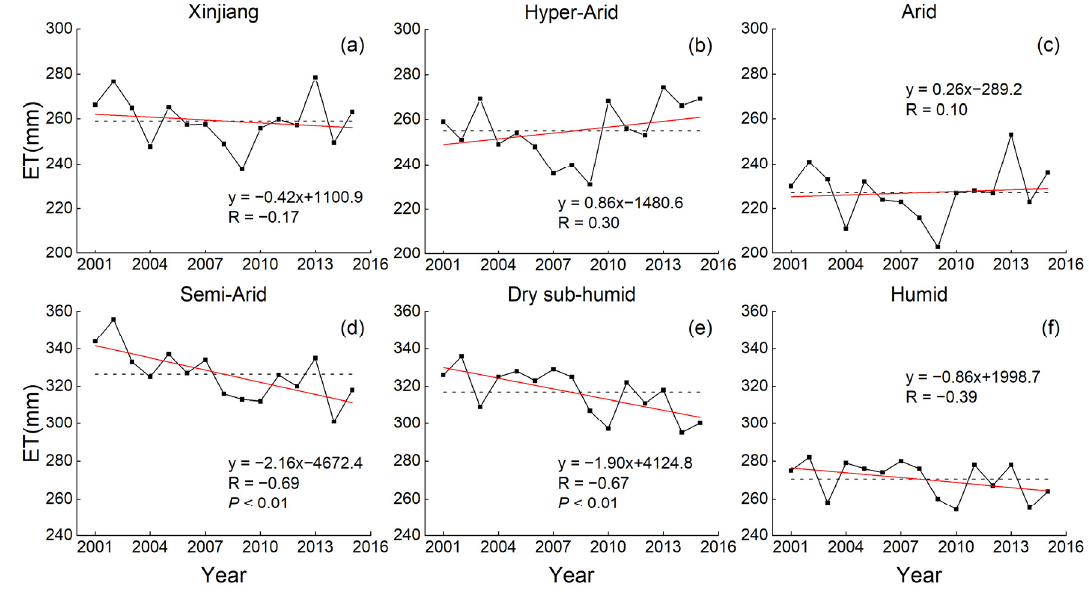
Figure 6. Inter-annual variations in ET in different climate zones from 2001 to 2015 are shown for ( a ) the entire Xinjiang region, ( b ) hyper-arid region, ( c ) arid region, ( d ) semi-arid region, ( e ) dry sub-humid region, and ( f ) humid region.